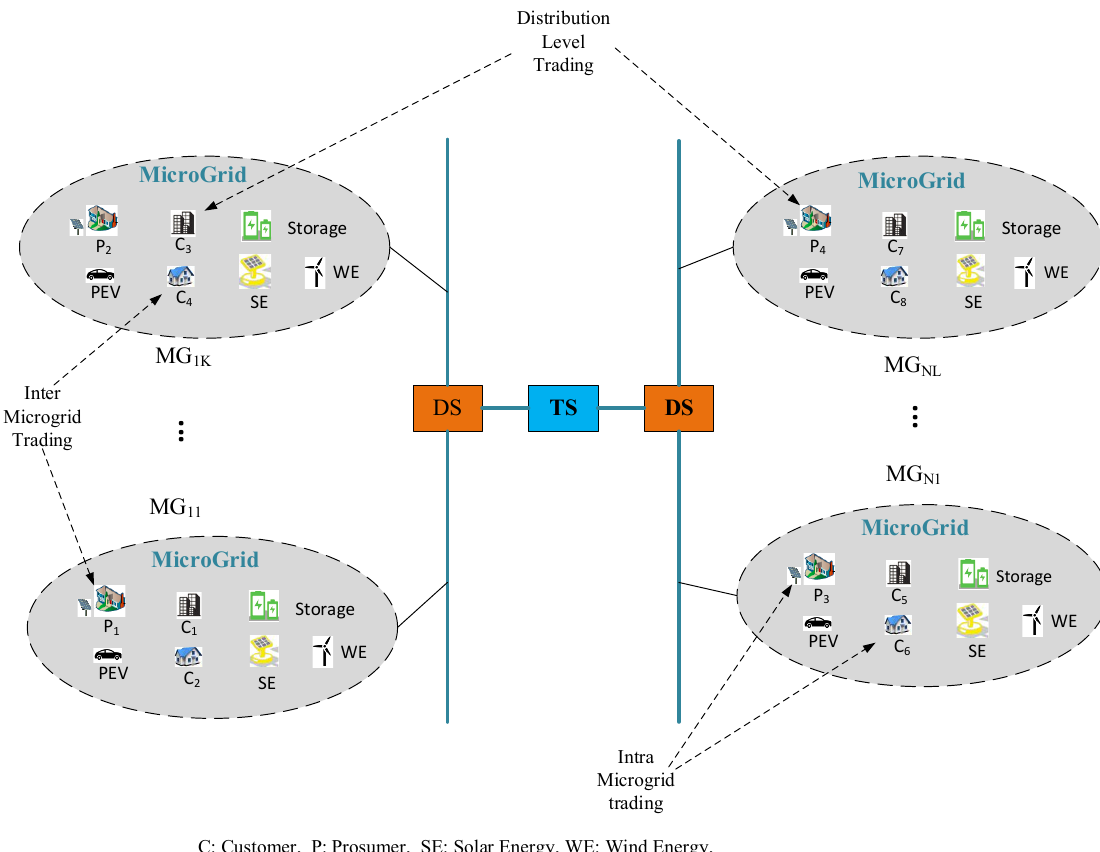
Figure 1. Hierarchical Architecture of P2P DET. Figure 2. Hierarchical Architecture of P2P